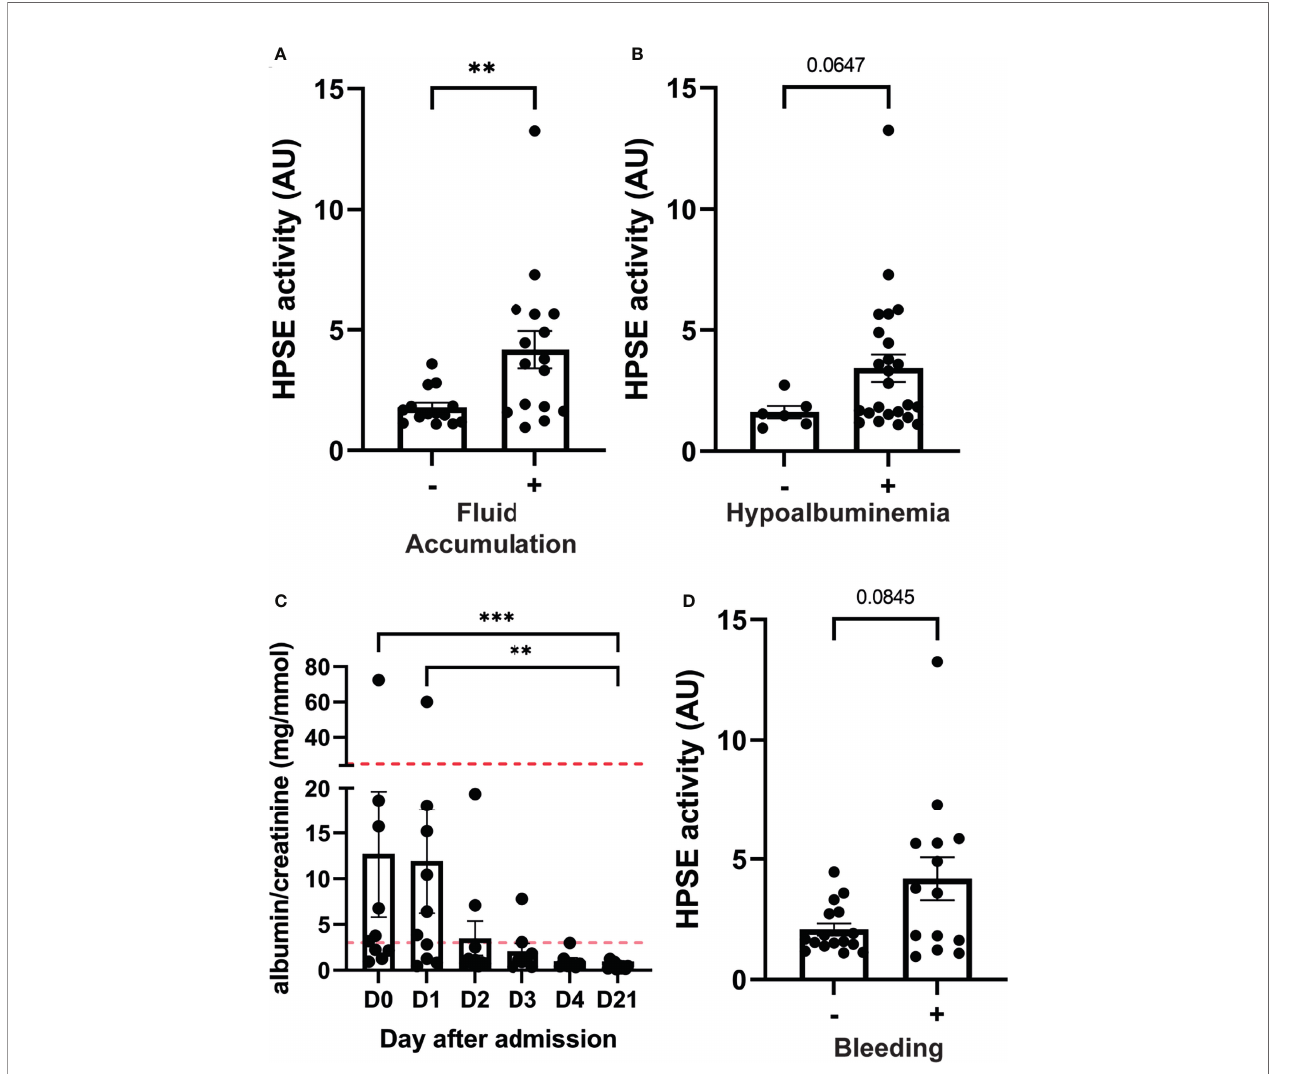
FIGURE 2 | HPSE activity in dengue patients is associated with plasma leakage and bleeding manifestations. Plasma HPSE activity categorised according to the presence of (A) Fluid accumulation at enrollment and follow up; Fluid accumulation was determined by the presence of ascites and/or pleural effusion by ultrasonography, (B) hypoalbuminemia (plasma albumin level <3 g/dL), and (C) bleeding; Bleeding was determined by the presence of one or more bleeding manifestation according to WHO bleeding scale. (D) Urinary albumin/creatinine ratio in dengue patients over time (n=10). Horizontal lines indicate microalbuminuria (ACR ≥ 3.5 mg/mmol (female) or ≥ 2.5 mg/mmol (male)) and macroalbuminuria (ACR ≥ 25 mg/mmol (female)). Data were presented as mean ± SEM and distribution normality was assessed with D ’ Agostino & Pearson omnibus normality test. Statistical differences were calculated using